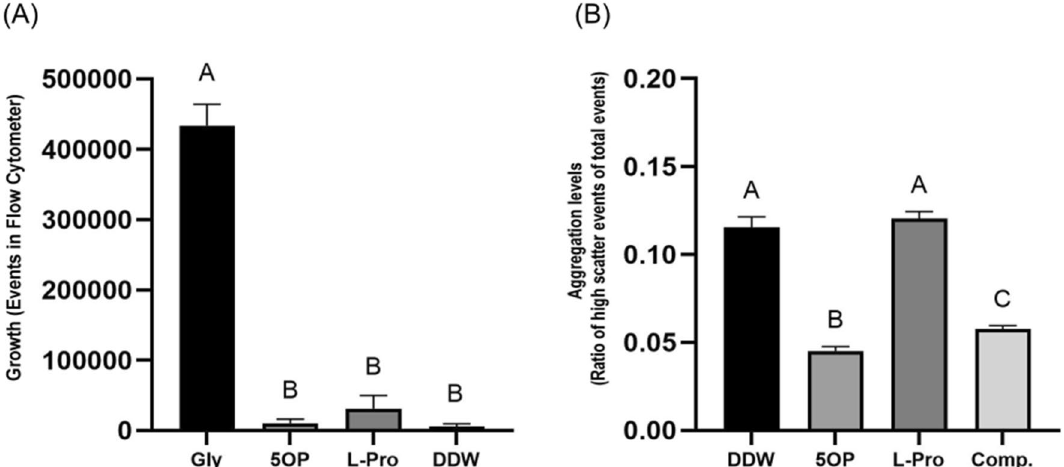
Figure 3. Growth and aggregation of a putP knockout mutant. ( A ) Growth of a Salmonella putP knockout mutant in minimal buffer supplemented with either 8 mM 5OP (5OP), 8 mM l-proline (l-Pro), 25 mM glycerol (Gly) as a positive control, or water as a negative control (DDW). Shown are the total number of events counted by running 5 µl of culture through a flow cytometer. Average and standard deviation of 4 biological repeats are shown. One-Way ANOVA was conducted and Geisser-Greenouse correction was used. ( B ) Quantification of aggregation by flow cytometry of the same strain after exposure to 5OP, l-proline (l-Pro), DDW, or both at a 1:10 ratio (8 mM 5OP and 80 mM l-proline, Comp.). Shown is the ratio of high light scatter events out of the total events. Due to variation between experiments a representative experiment out of three is shown in ( B ). One-Way ANOVA was conducted. Treatments denoted by different letters are statistically different at a P value of 0.01 or less for ( A ) and 0.001 or less for ( B ). Standard deviation is shown.